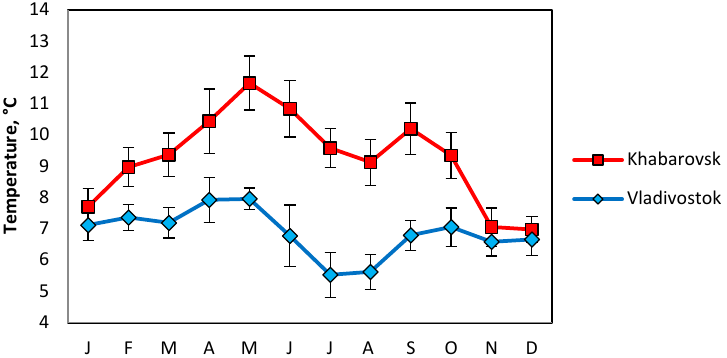
Figure 5. Intra-annual fluctuations of DTR from January to December in Khabarovsk and Vladivostok. Black bars show standard deviations.